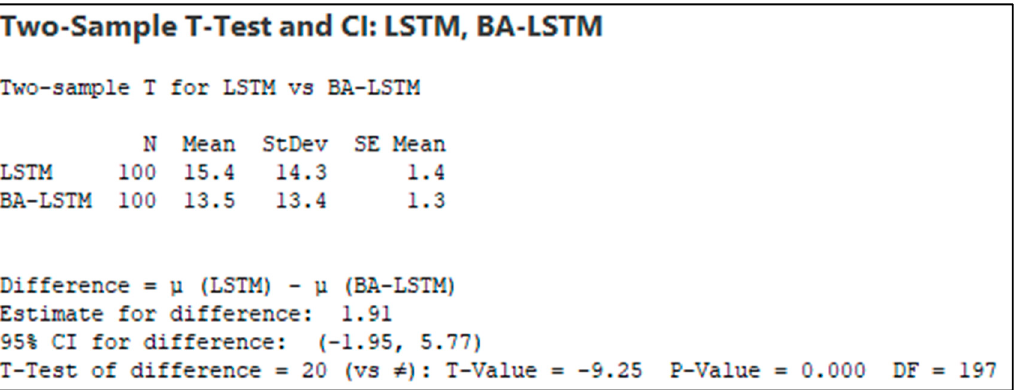
Figure 18. The two-sample t -test between LSTM and BA-LSTM algorithms.